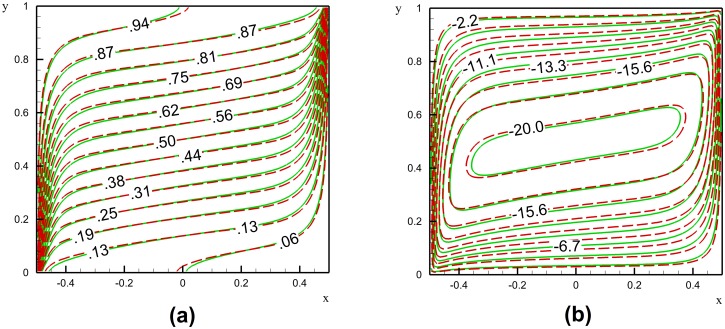
A comparison between the isotherms (a) and streamlines (b) of a nanofluid and the base fluid in a glass balls porous medium when Ra = 1000, A = 1, α = 0, φ = 0.05 and ε = 0.5; the dashed red lines are base fluid and the solid green lines are the nanofluid (a) and (b).